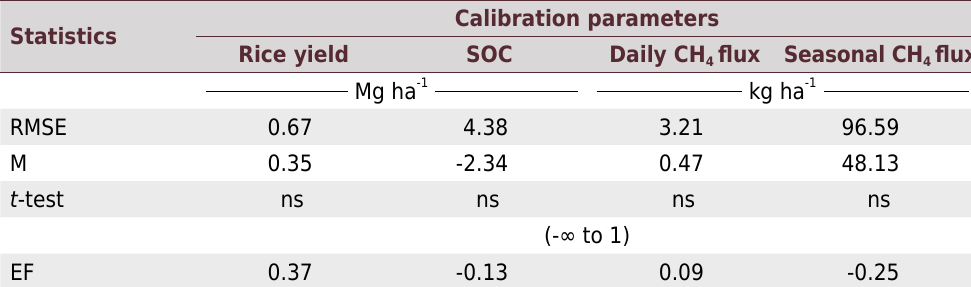
Table 2. Statistical analysis of simulated and observed parameters under conventional tillage treatment (model calibration) in a long-term experiment at the Rice Research Station in southern Brazil